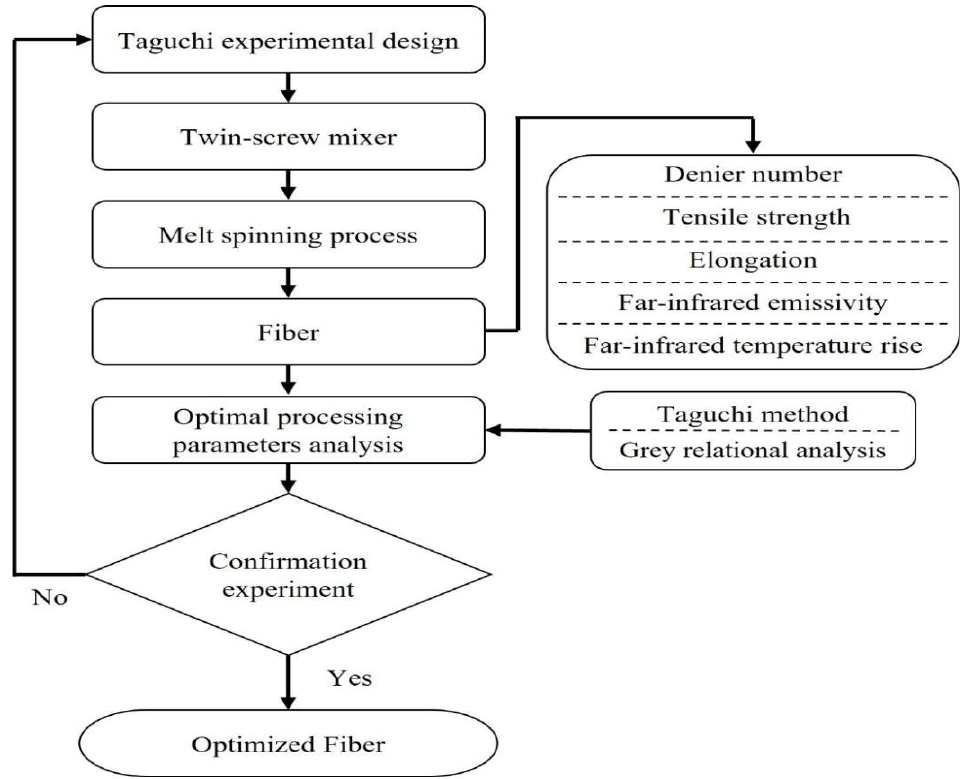
Figure 4. The flowchart of the optimized design